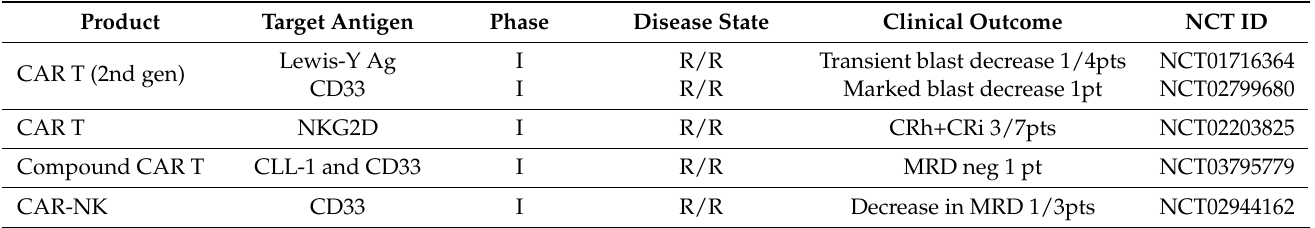
Table 2. Summary of preliminary results of CAR T/CAR NK cell therapy for